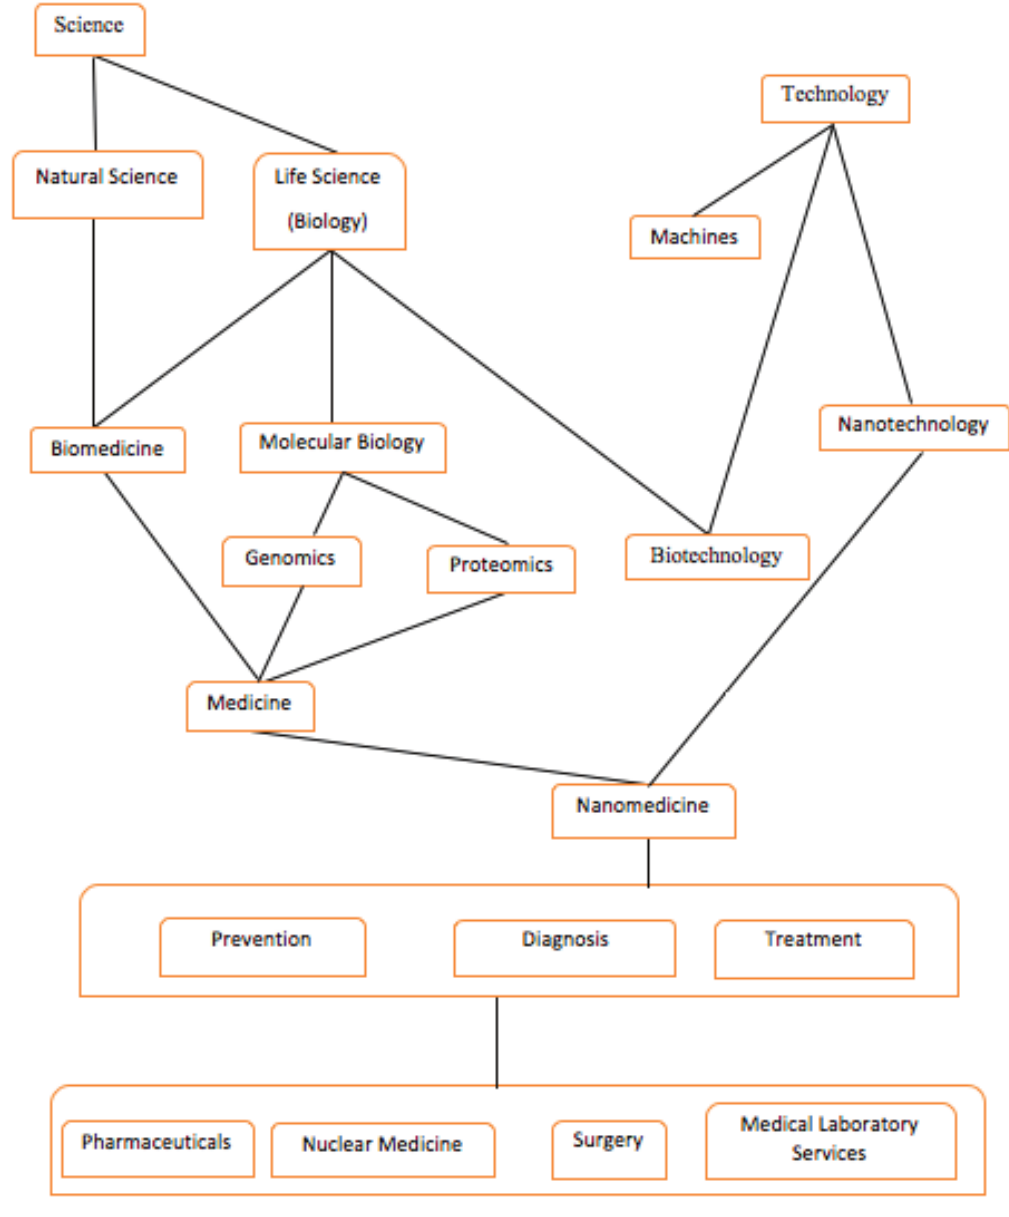
Figure 2: Evolution and convergence of some diverse related scientific and technological disciplines in